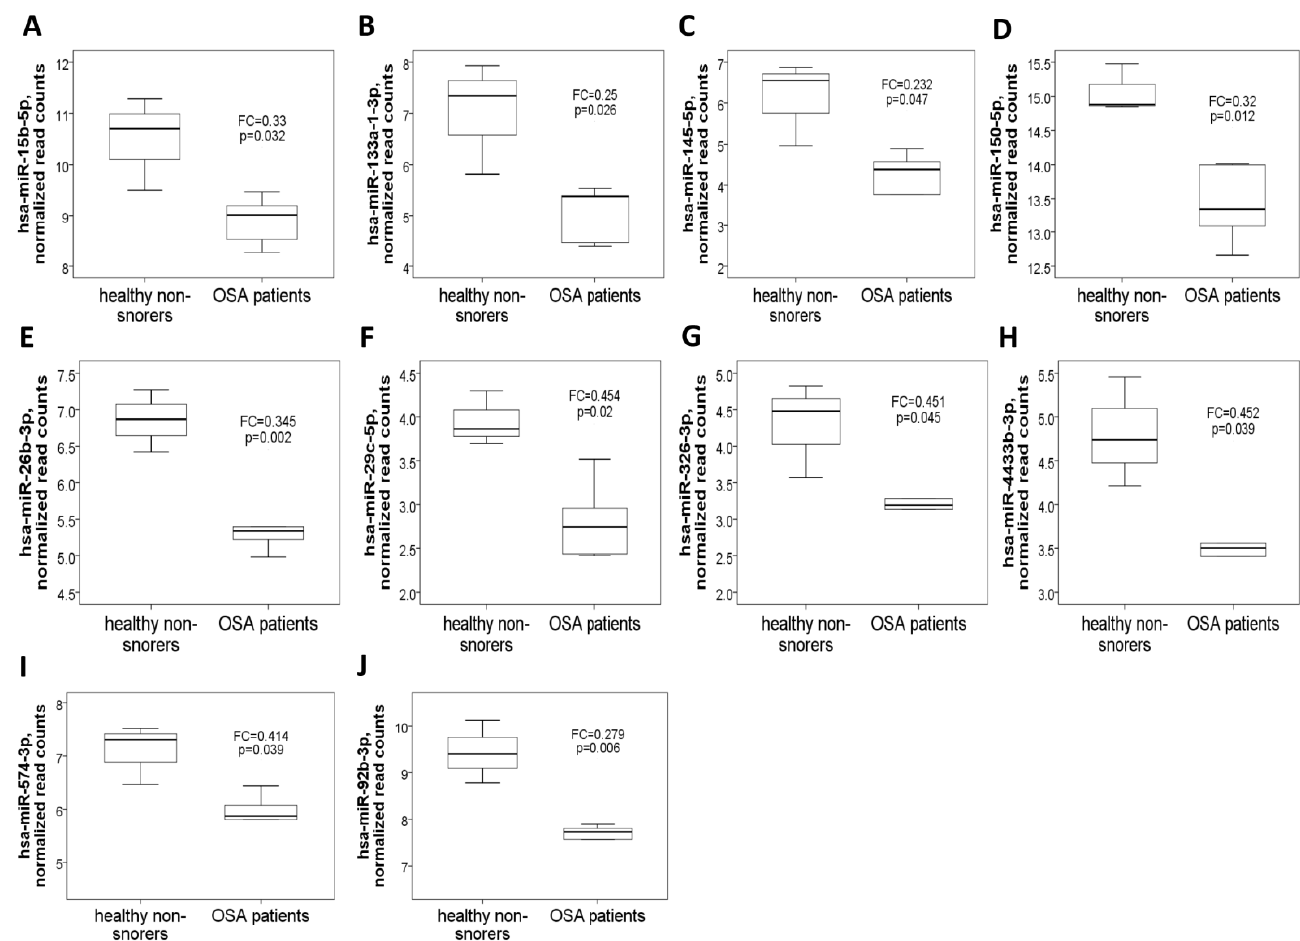
tients (2.8 ± 8.2-fold change, Figure 5D) versus either PS (43.8 ± 97.7 fold change, adjusted p = 0.004) or OSA on CPAP (15.4 ± 21.1 fold change, adjusted p < 0.001) group. In treatment- naïve OSA patients and PS subjects, miR-92b-3p expression was negatively correlated with AHI (R = − 0.289, p = 0.02, Figure 5E), and positively correlated with mean SaO2 (R = 0.248, p = 0.047, Figure 5F).